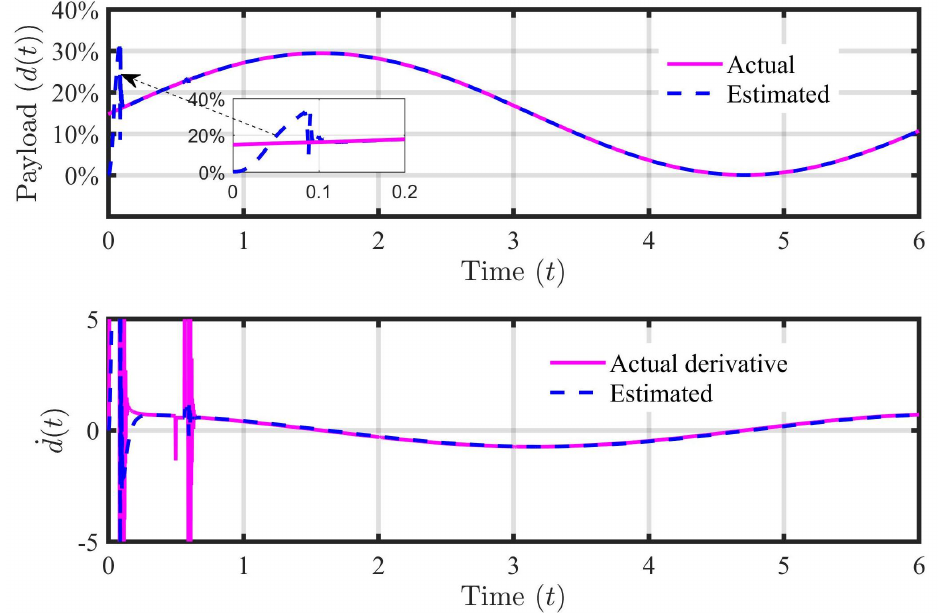
Figure 2. DESO − based estimation of the sinusoidal payload disturbance ( d ( t ) ) and its first-order derivative ( ˙ d ( t )